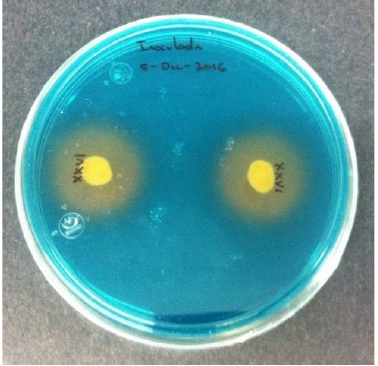
Figure 2: Siderophores production results in the OSM2 strain isola- ted from agricultural soil